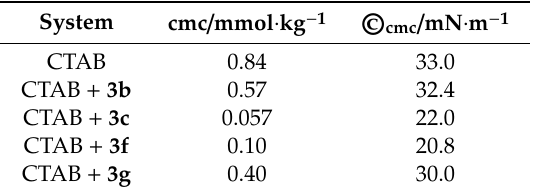
Figure 1. Surface tension plots and cmc determination at 25 °C of aqueous surface-active ionic liquid (SAIL)/CTAB mixtures: ( a ) surface tension vs. the logarithm of total SAIL+CTAB concentration expressed in molality; the cmc are obtained from the intersection points of the linear fits in each system; ( b ) cmc vs. molar fraction of SAIL 3c in mixtures of SAIL 3c /CTAB, showing the marked effect of the SAIL in cmc reduction. Table 2. Critical micellar concentration ( cmc ) and surface tension at the cmc ( © cmc ) for CTAB and different CTAB/SAIL solutions with a molar fraction of SAIL, x SAIL , equal to 0.10.